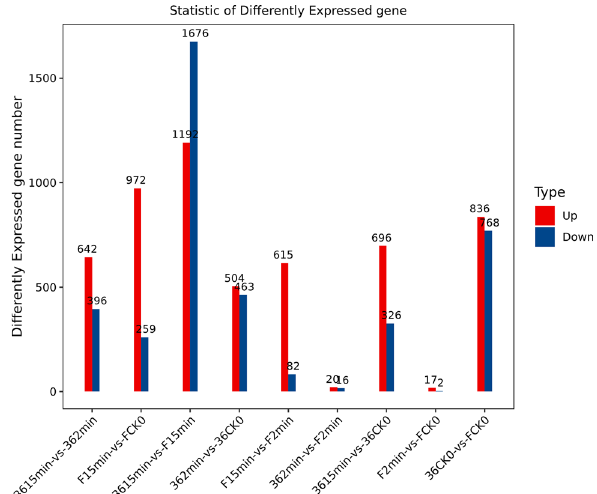
Figure 3. Differentially expressed genes (DEGs) in each comparison